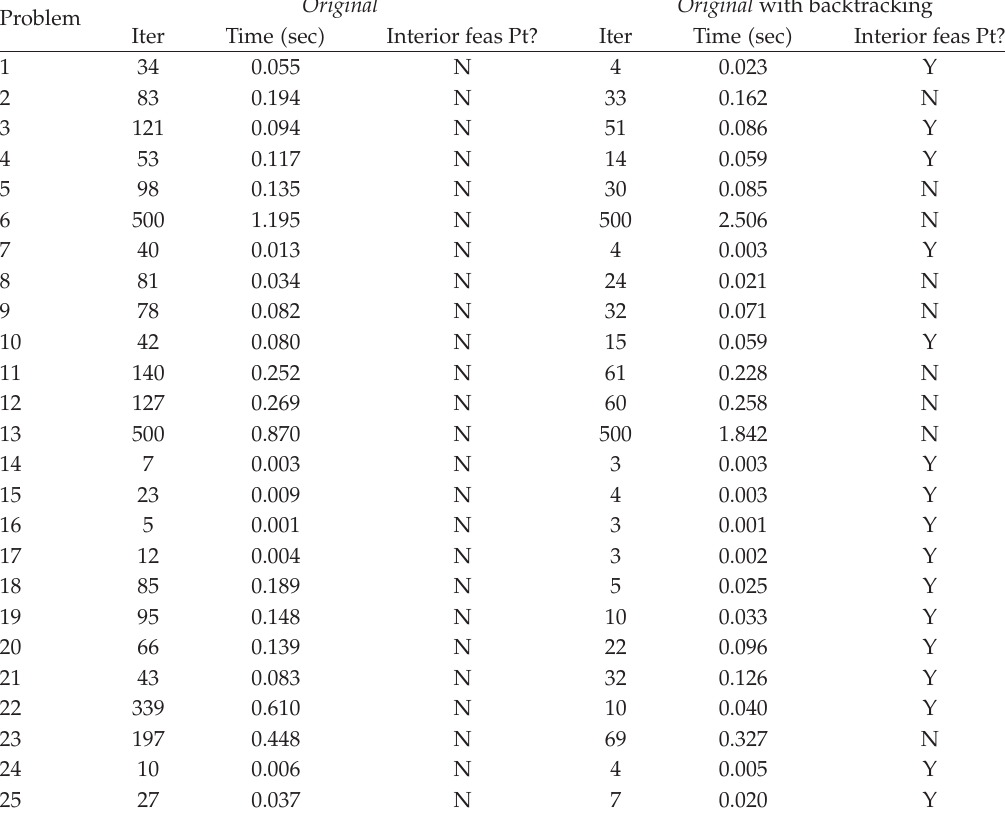
Table 3: SOCs: comparison of Original method and Original method with